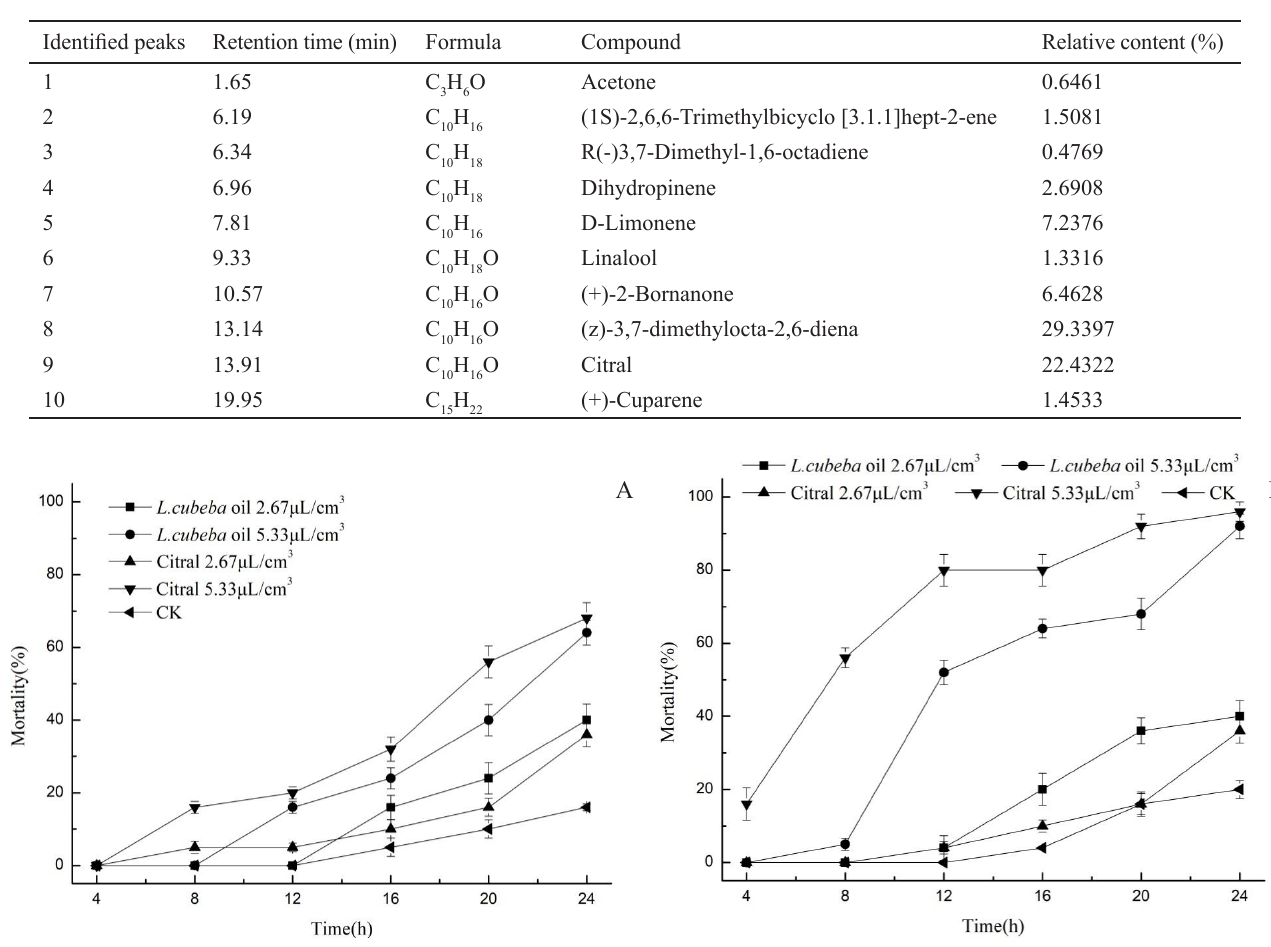
Fig 2 . Mortality of workers (A: macroergate, B: microergate) after treating for 24 hours of Litsea cubeba oil and